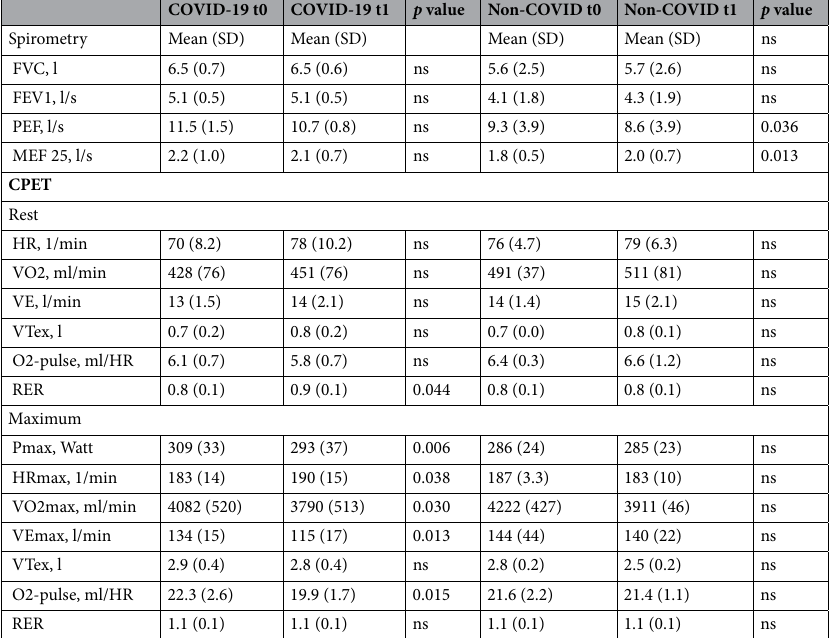
Table 2. Results of spirometry and incremental cardiopulmonary exercise test (CPET). FVC Forced vital capacity, FEV1 Forced expiratory volume in the first second, PEF Peak expiratory flow, MEF Maximal t0 Routine CPET during preparation phase in summer 2020, t1 post-SARS-CoV-2 infection (COVID-19) in winter 2020 or during other cardiac outpatient diagnostics in winter 2020